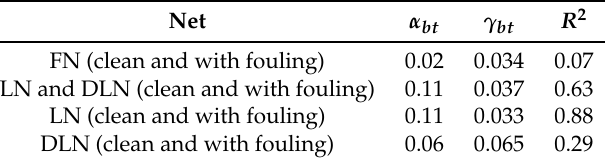
Table 7. Coefficients γ and α for a t = α at S n + γ at and b t = α bt S n + γ bt fitting for tangential drag force